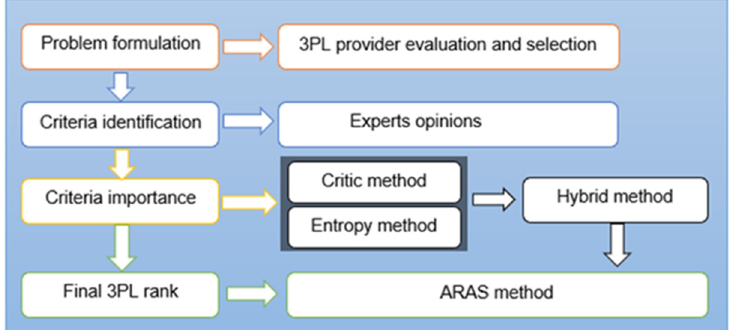
Figure 1. A flowchart of the methodology used for 3PL service provider evaluation and selection (Source: Authors).